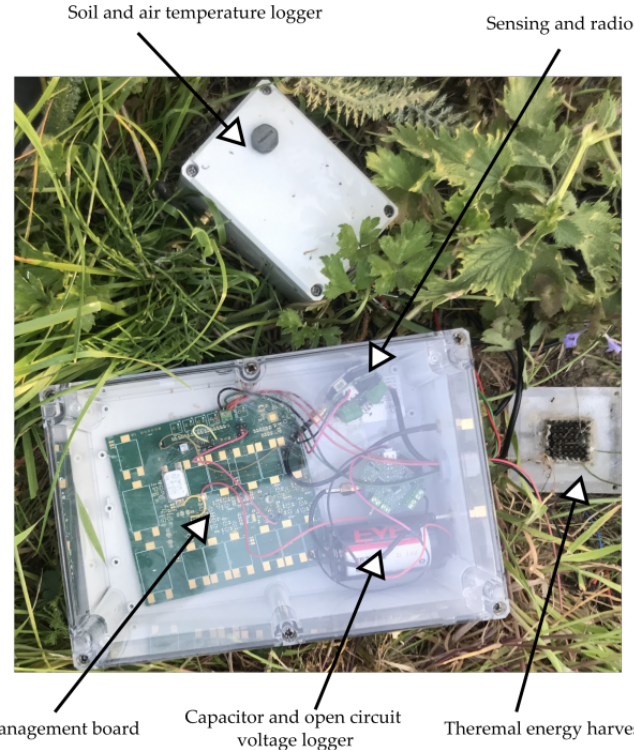
Figure 11. Energy-harvester system deployed in the CDE Campus of University of Antwerp in Belgium.